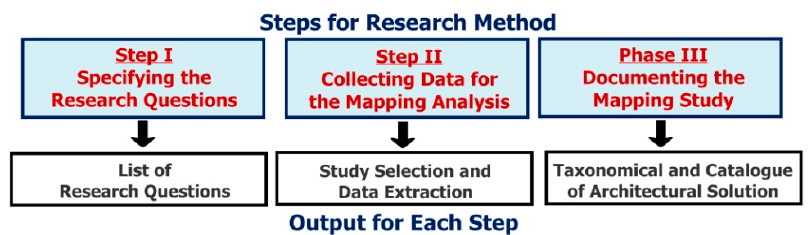
Figure 4. An Overview of the Research Methodology for Conducting the Mapping Study.